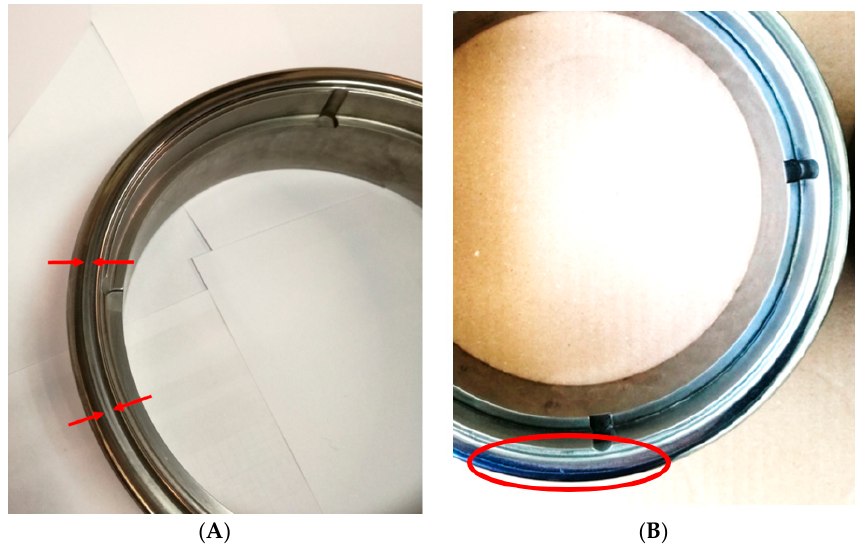
Figure 17. ( A ) Minor wear signs (indicated by red arrows) on the TiAlN-coated pressure ring after 90,000 stamping cycles; ( B ) Uncoated pressure ring after 90,000 stamping cycles with clear tin transfer on the surface and wear marks (indicated by red